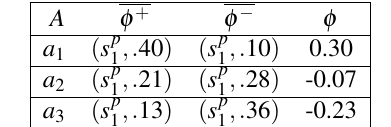
Table 13. Computed leaving flows, entering flows and net